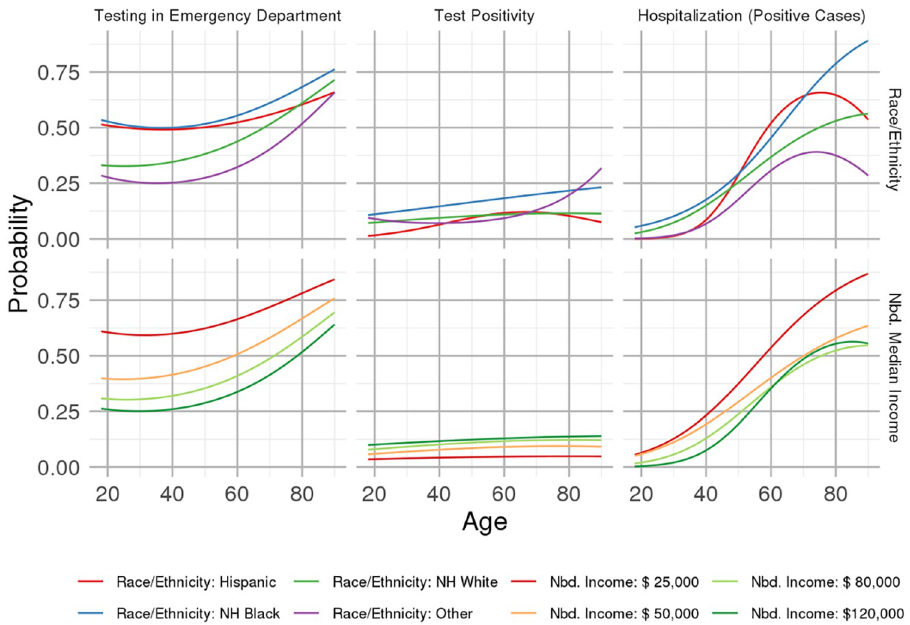
Fig 4. Incidence of testing in the ED (as opposed to any other location), COVID-19 test positivity and hospitalization (among those testing positive for COVID-19), as a function of age, for categories of patients defined according to race/ethnicity (adjusting for median income) and neighborhood median income (adjusting to the modal race/ethnicity, non-Hispanic White).